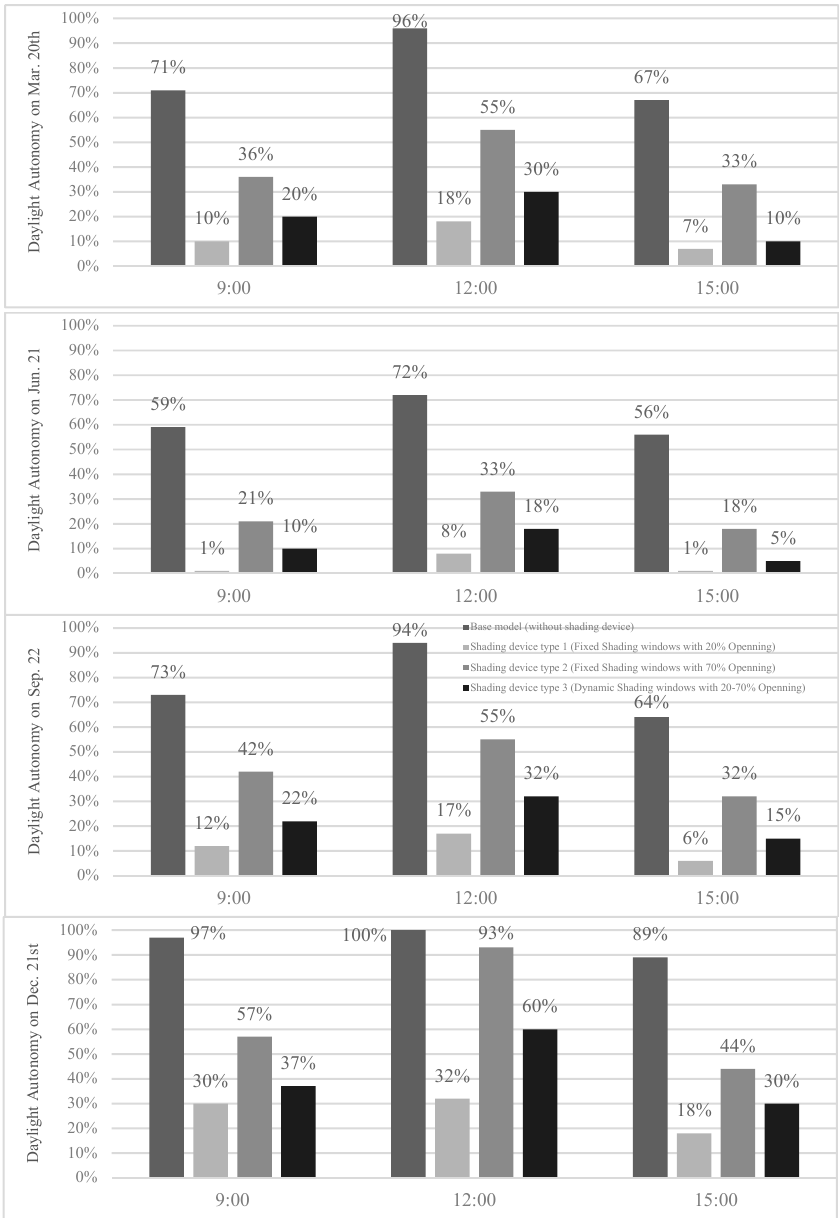
Figure 8. Daylight Autonomy analysis on each critical day of the year for each shading device type.